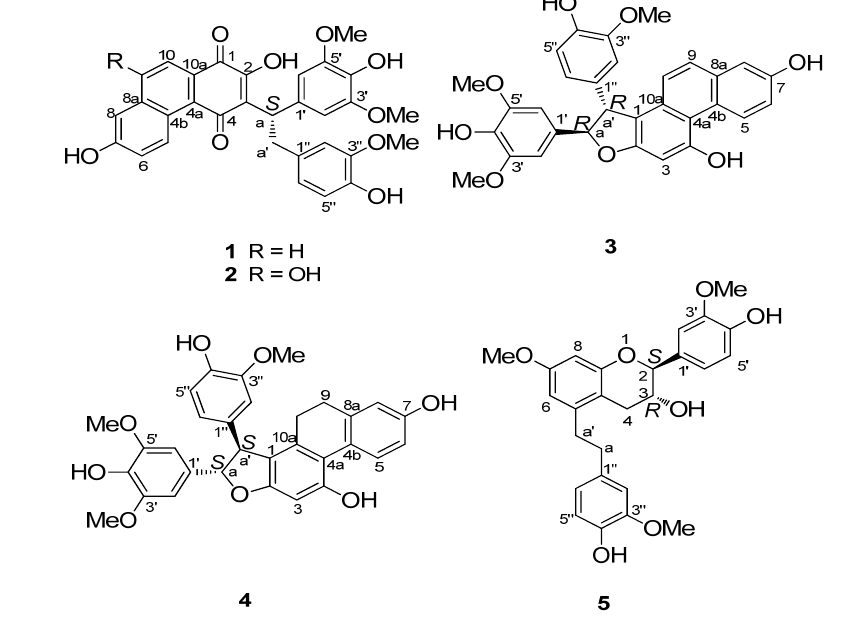
Figure 1. The chemical structures of compounds 1 – 5 .